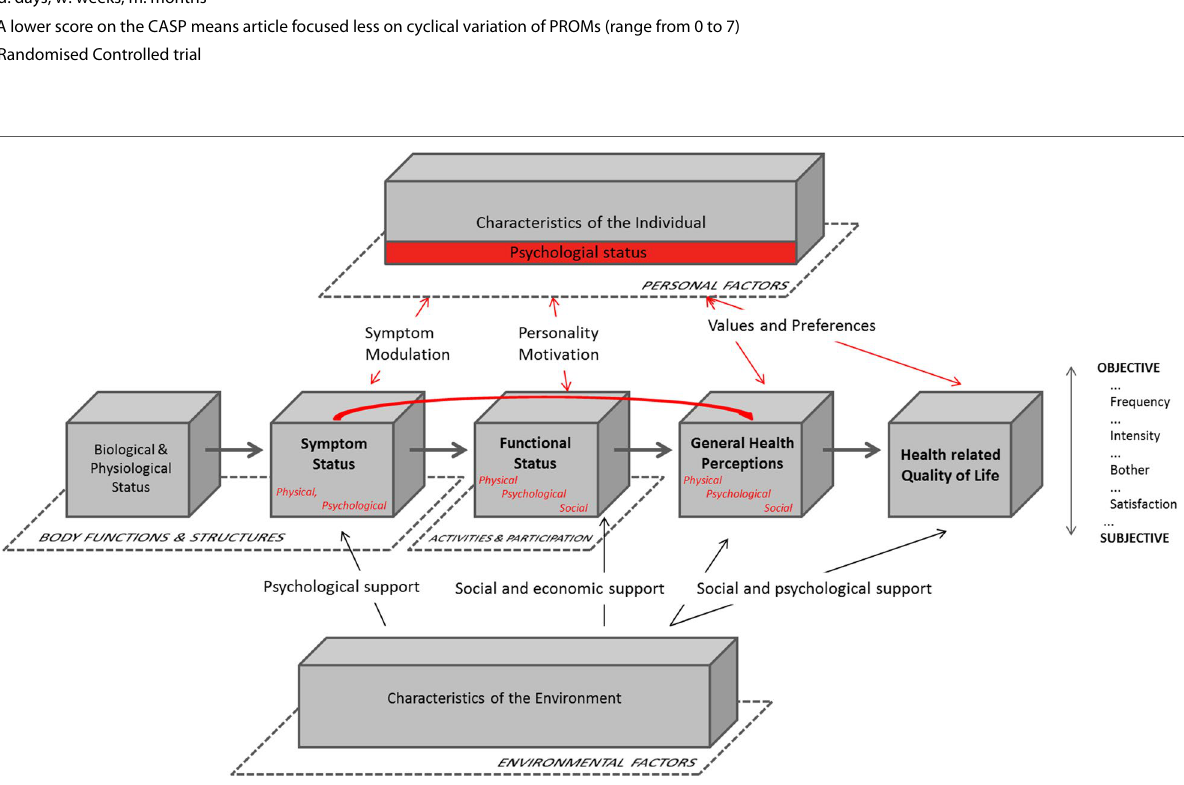
Fig. 1 Revised Valderas and Alonso model of Patient Reported Outcomes